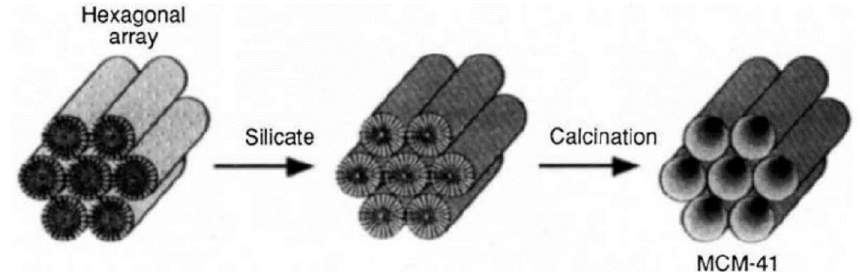
Figure 2. Schematic representation of the liquid crystal templating procedure employed by Kresge et al. Hexagonal arrays of cylindrical micelles form with the polar groups of the surfactants (light grey) to the outside. Silicate species (dark grey) then occupy the spaces between the cylinders. The final calcination step burns off the original organic material, leaving hollow cylinders of inorganic material. MCM-41 stands for Mobil Composition of Matter No. 41. Reprinted with permission from Kresge et al., Nature 1992 , 359 , 710–712.